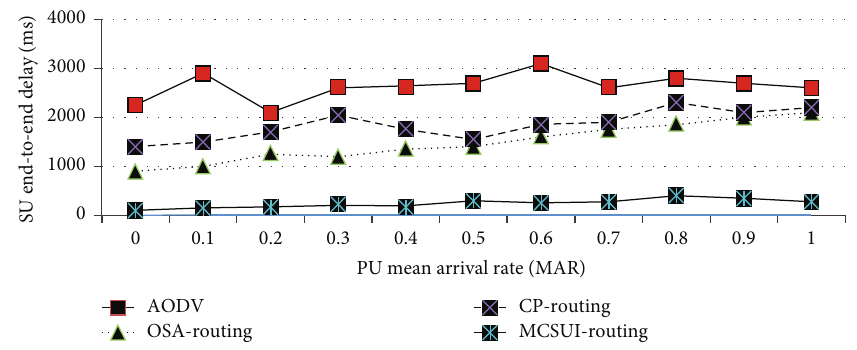
Figure 20: EED of SU for PU’s sd of MAR as 0.8